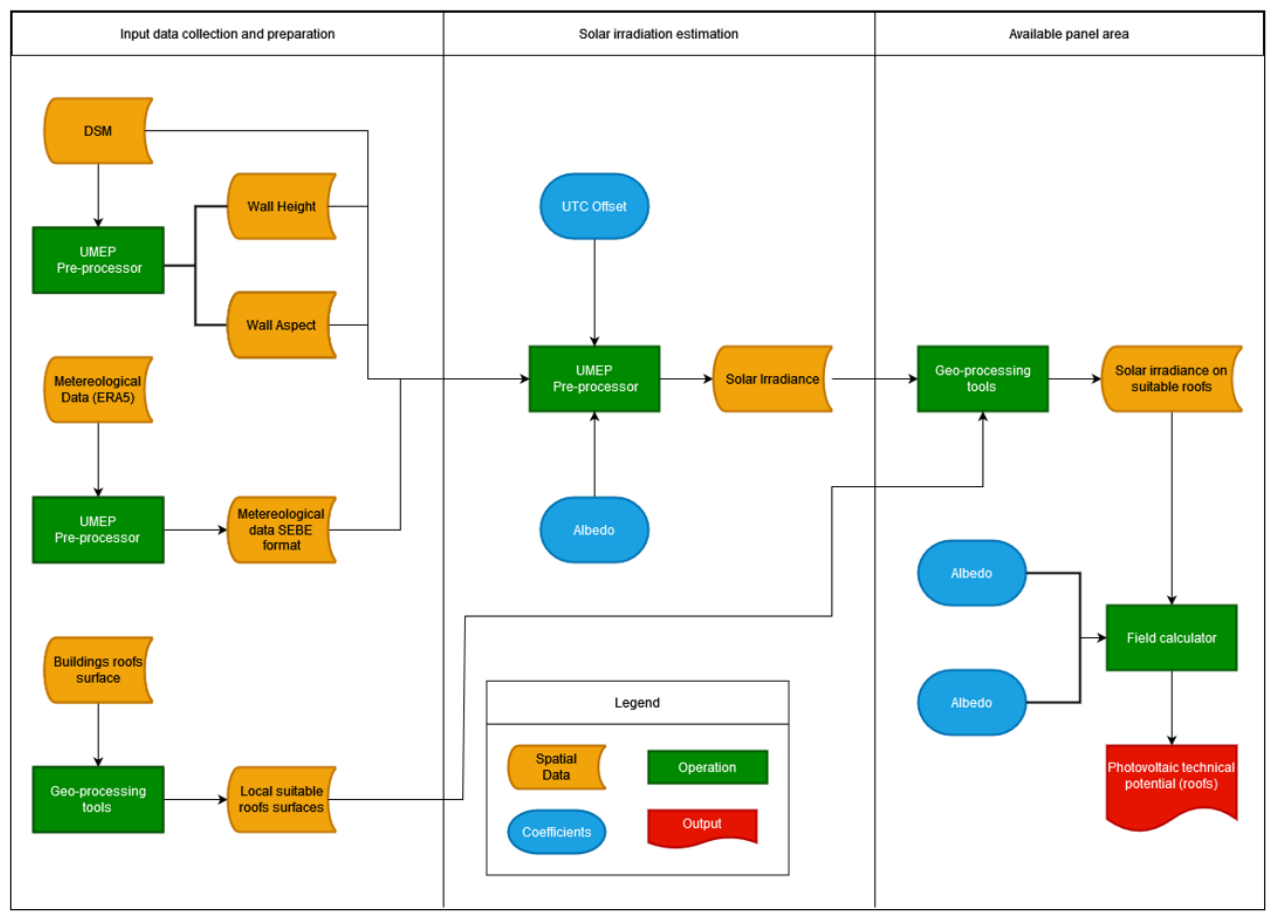
Figure 11. Solar assessment